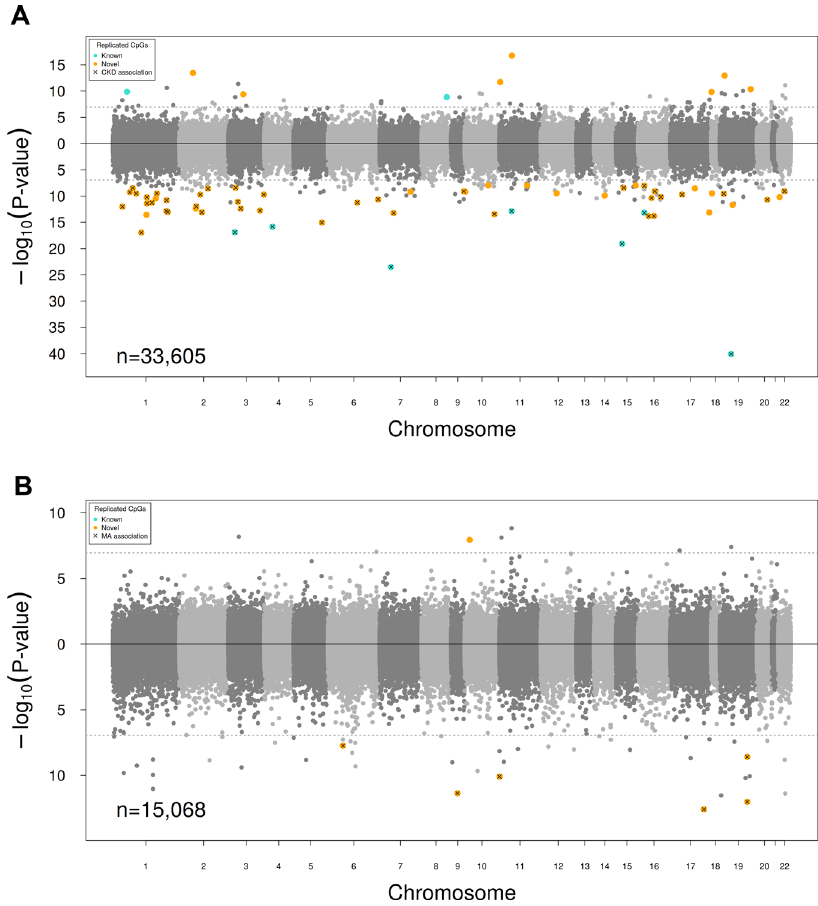
Fig. 1 EWAS results of eGFR and UACR. Chicago plots of the epigenome-wide association study (EWAS) results for estimated glomerular fi ltration rate (eGFR) ( A ) and urinary albumin-to-creatinine ratio (UACR) ( B ) using the combined discovery and replication sample. The sites are ordered by their chromosomal position on the x-axis, with their – log 10 P -value of the association Wald-test provided on the y -axis. CpGs positively correlated with the trait are plotted in the upper part, sites with negative correlation in the lower part. The dotted horizontal lines represent the level of signi fi cance ( P -value<1.1E − 7). Novel replicates sites are colored in orange, known replicated sites are colored in turquois, and sites that were additionally associated with the respective binary trait (chronic kidney disease [CKD]/ microalbuminuria [MA]) are marked with a